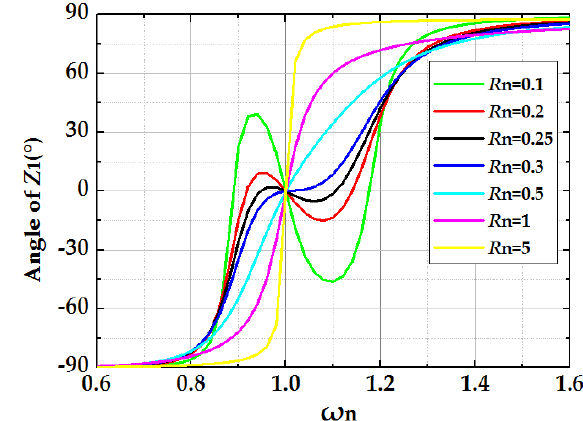
Figure 7. Impedance angle of Z 1 .